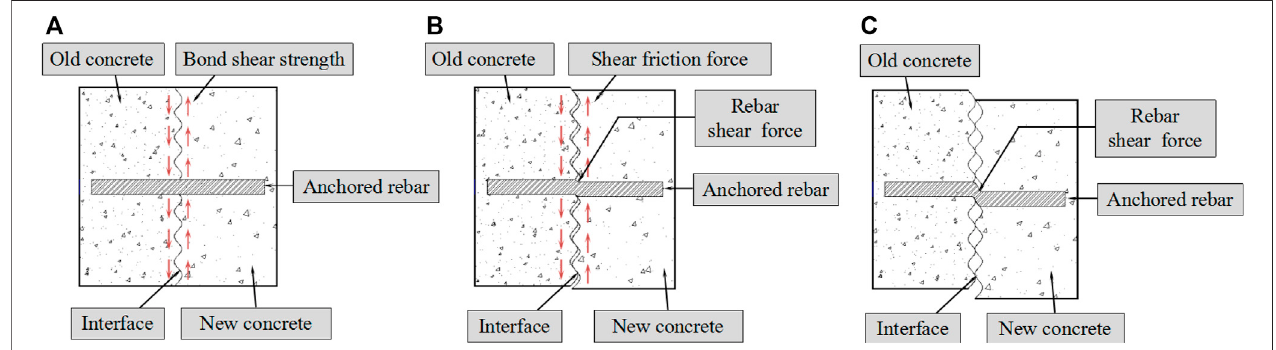
FIGURE 1 | The Old - New concrete interfacial bond slip process of the anchoring specimen: (A) Force state diagram of interface before bond slip; (B) Force state diagram after interfacial bond slip; (C) Force state diagram after interface separation.